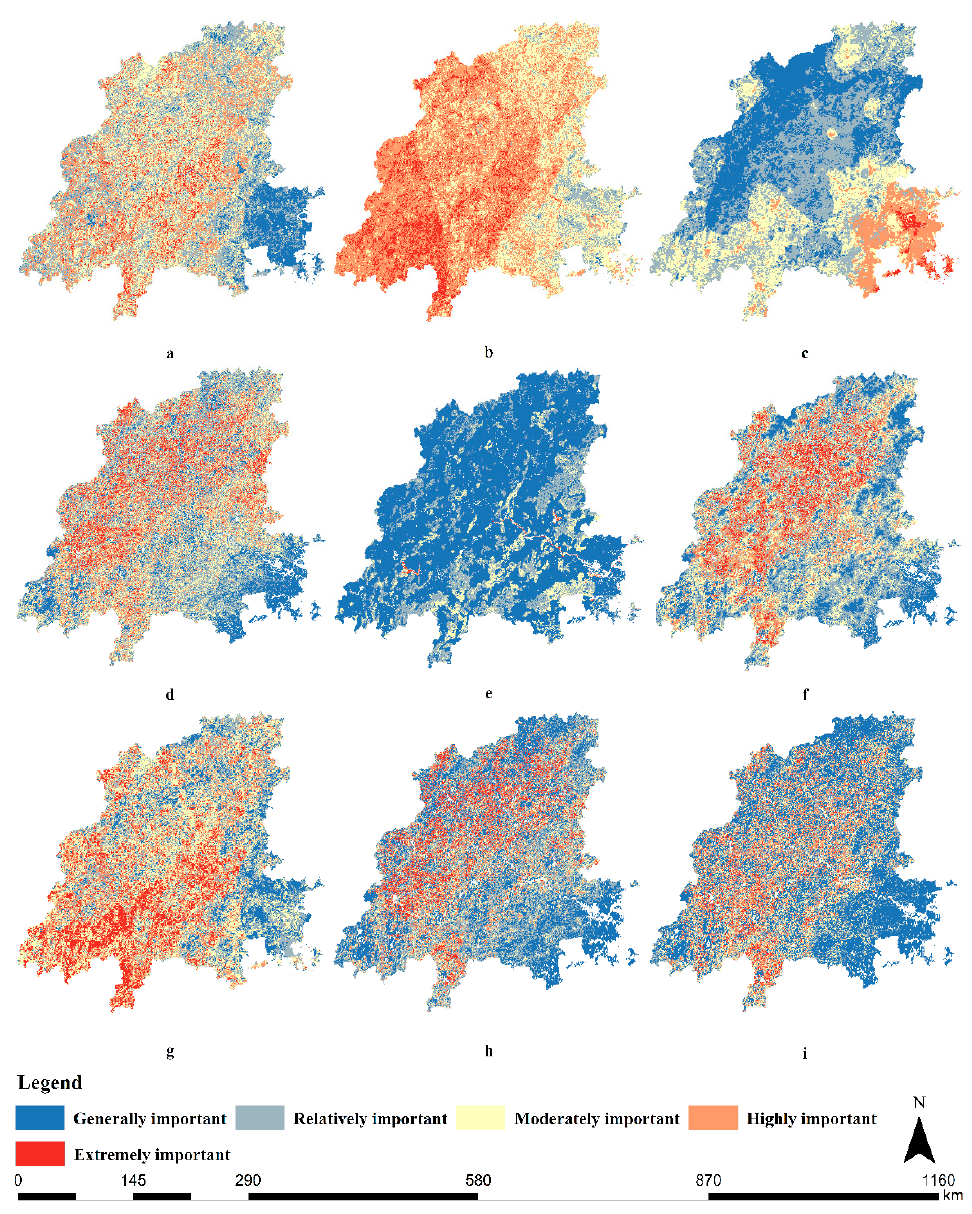
Figure 3. Assessment map of eco-environmental factors in the Minjiang River Basin. ( a ): Evaluation of sensitivity to soil and water loss. ( b ): Evaluation of soil erosion sensitivity. ( c ): Evaluation of sensitivity to land desertification. ( d ): Evaluation of the importance of the water conservation function. ( e ): Evaluation of the importance of the soil and water conservation function. ( f ): Evaluation of the functional importance of biodiversity. ( g ): Comprehensive assessment of ecological sensitivity. ( h ): Comprehensive assessment of the importance of ecosystem function. ( i ): Comprehensive assessment of the ecological environment.